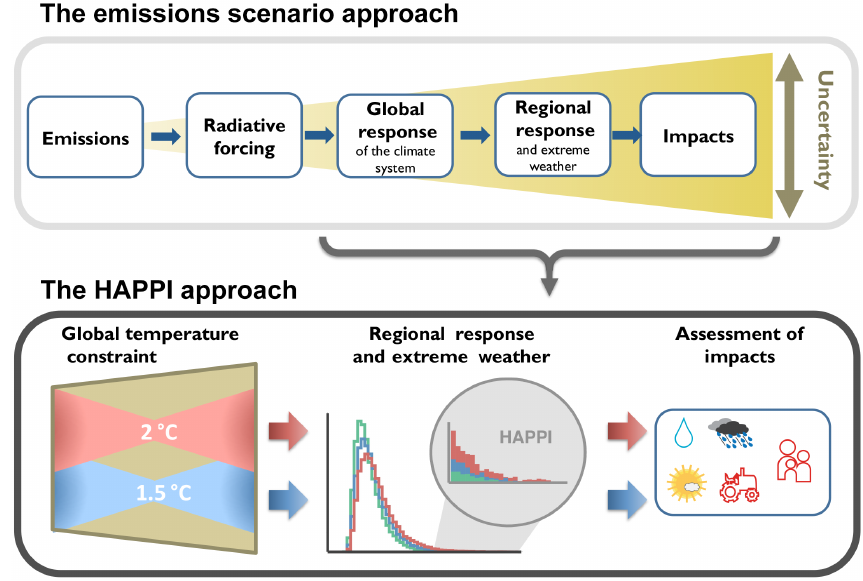
Figure 1. A schematic comparing the emission-scenario-based approaches (top), such as CMIP, with the HAPPI approach (bottom). The HAPPI approach flows from the constraint on global temperatures to the comparison of extremes using the large-ensemble approach to impact models. The histogram depicts an illustrative example of distributions for extreme-event indicators (such as maximum daily temperature) for the present day (green), 1.5 ◦ C (blue) and 2 ◦ C (red) above pre-industrial levels. Table 1. Table of models that will likely contribute to HAPPI, with specifications and expected number of simulated model years per experiment tier. Regional climate models (RCMs) are also listed. In addition to the simulations detailed here, modelling centres will run five ensemble members of 1959 to 2015 conditions for bias-correction